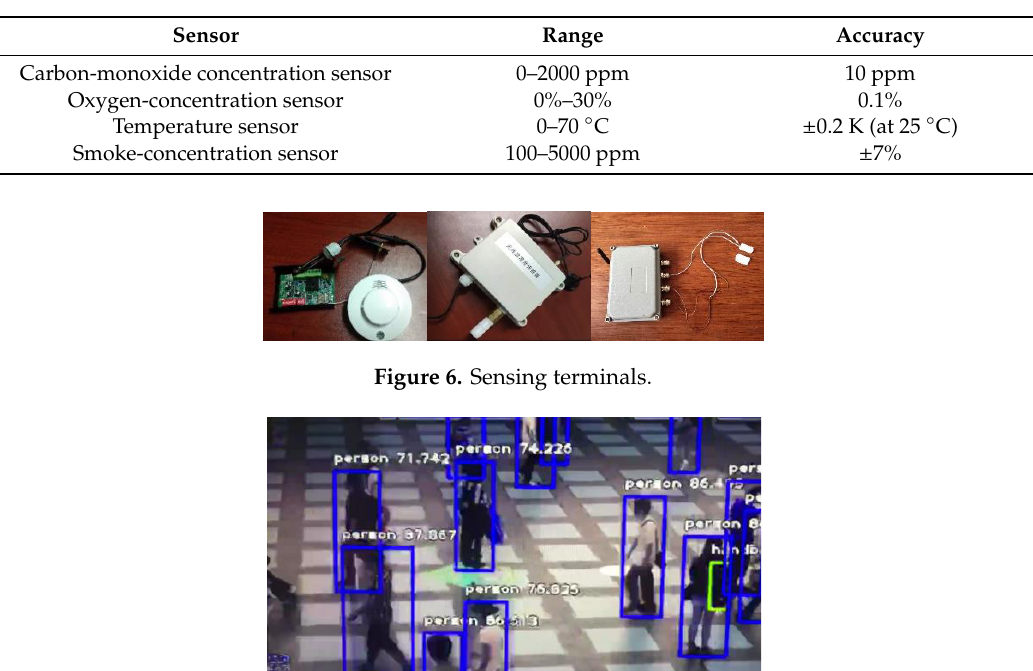
Table 1. Sensor parameters.